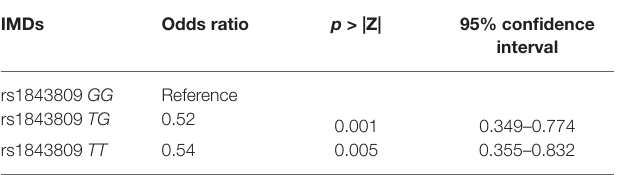
TABLE 3 | Association between tryptophan hydroxylase 2 gene rs1843809 and internalizing mental disorders (IMDs).